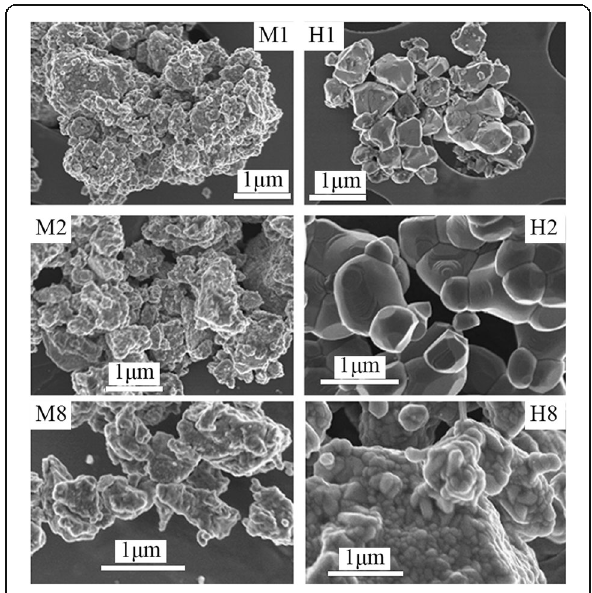
Fig. 5 SEM images of the corresponding to samples M1 and H1 ( x = 0), M2 and H2 ( x = 0.25), and M8 and H8 ( x = 1.0). The samples in the La 1-x Sr x MnO 3± δ (0 ≤ × ≤ 1) system with the first step after milling refer to M samples and after heated at 1100 °C under air atmosphere during 12 h refer to H samples. Reproduced